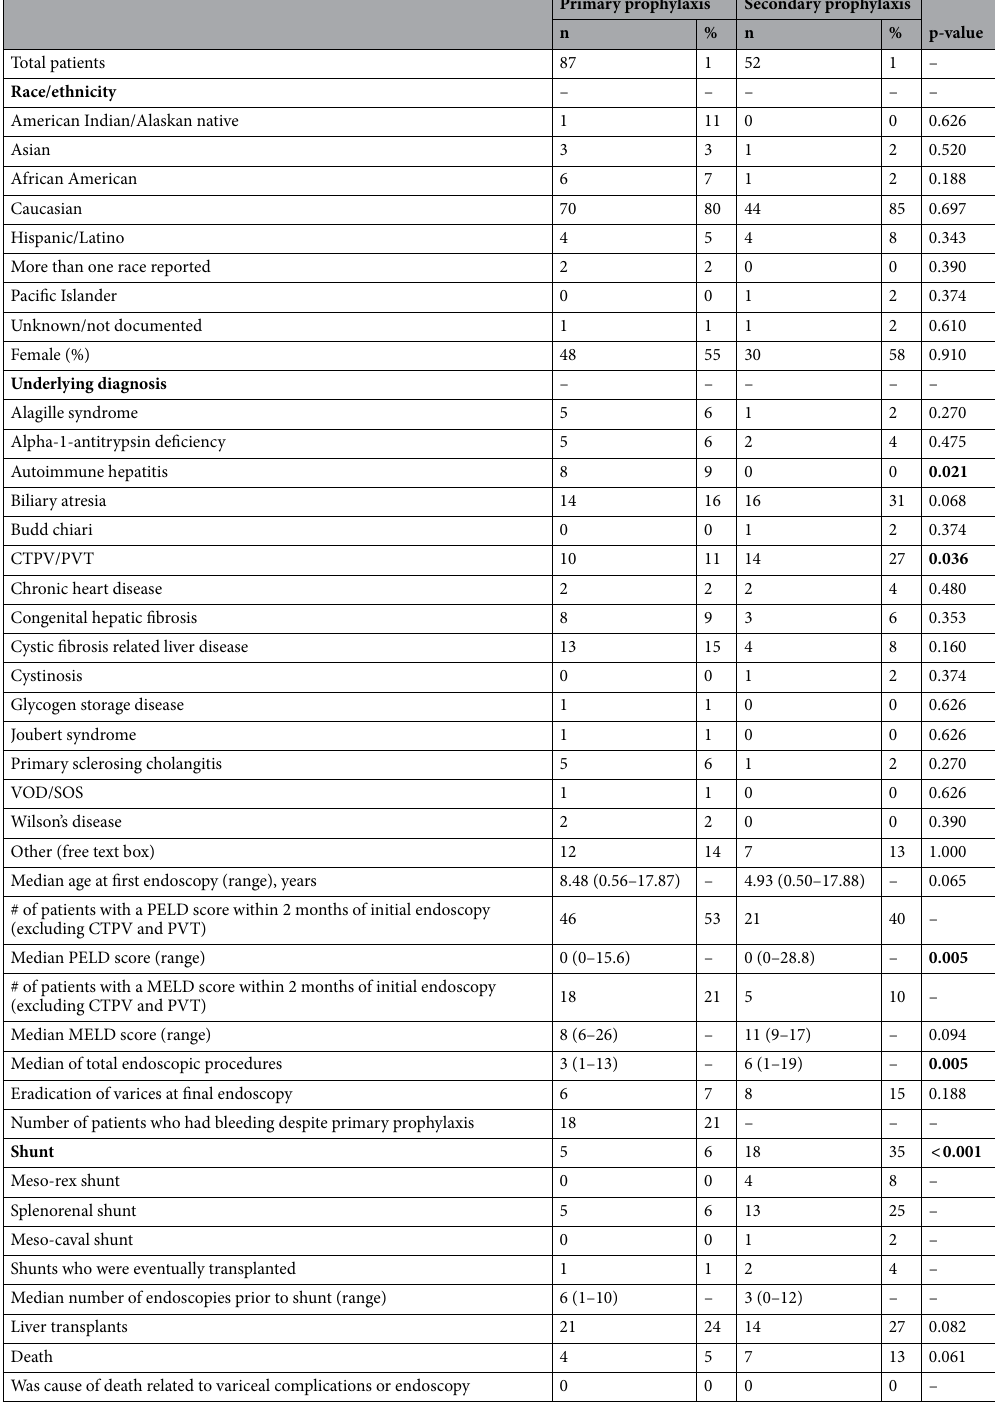
Table 1. Patient level characteristics of primary and secondary prophylactic endoscopy, p-value < 0.05 bolded. CTPV cavernous transformation of the portal vein, PVT portal vein